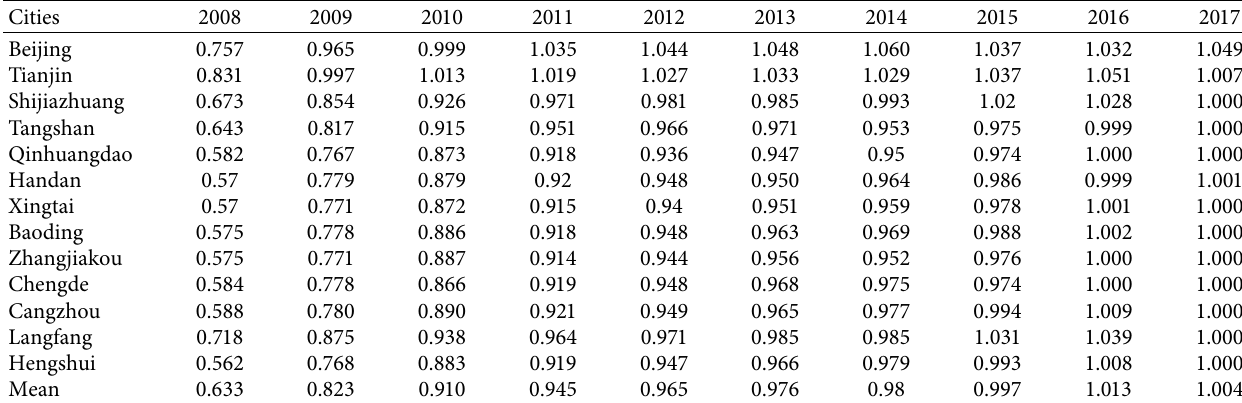
Table 5: Malmquist index of Beijing-Tianjin-Hebei Metropolitan (2008–2017).